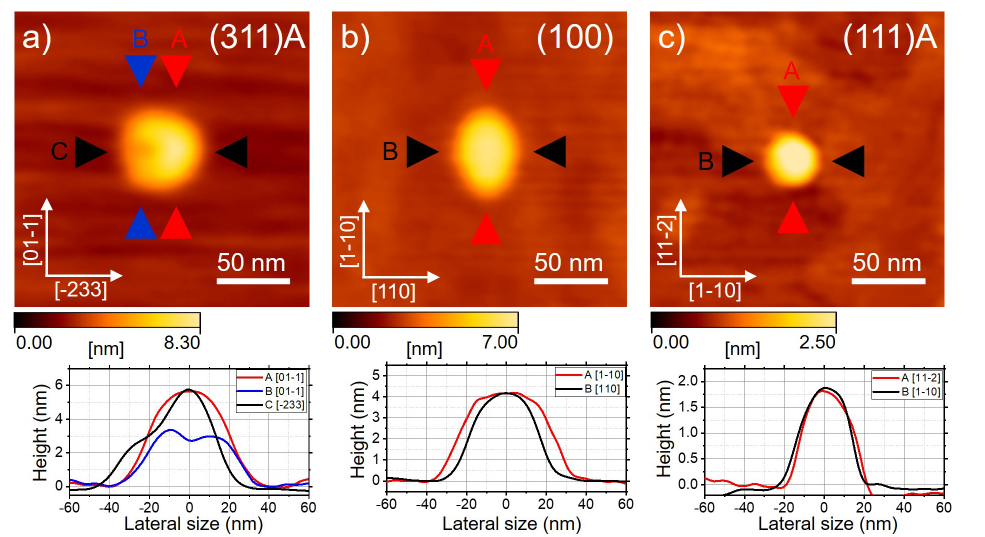
Figure 1. ( a ) Atomic force microscopy (AFM) image of a quantum dot (QD) grown on the (311)A surface for the sample described in [69]. ( b ) AFM image of a QD on the (001) surface for the sample described in reference [71]. ( c ) AFM image of a QD on the (111)A surface. In the bottom panels, we plot the cross-sectional profiles of the QDs in different crystallographic directions as marked in the images. The sizes of the QDs on the different substrates are not linked to the surface on which they were grown. The chosen QDs are representative of their kind regarding shape. However, they are likely incompatible with the photoluminescence (PL) spectra shown in the following figures due to their large